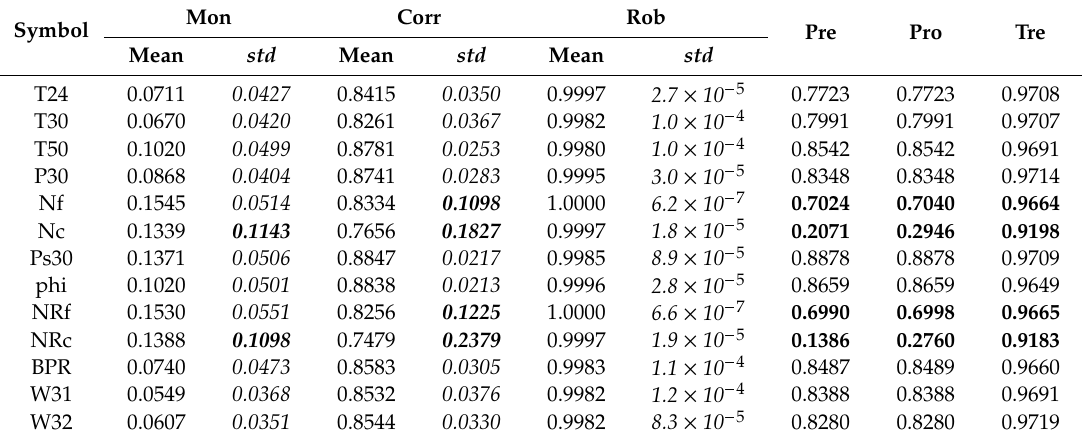
Table 3. Evaluation results of the sensors for the training data set of FD003 with the same failure mode of FD001. Mon Corr Rob Symbol